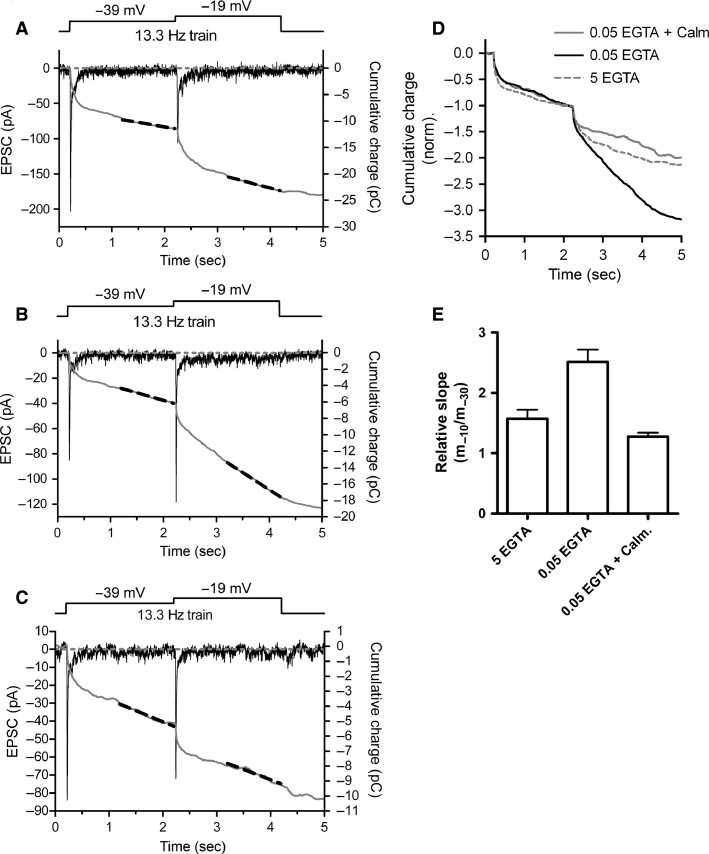
Reduced Ca2+ buffering promotes Ca2+/calmodulin-dependent acceleration of replenishment in cones. (A) Paired cone-HC recording in which the cone was stimulated with a train of depolarizing pulses (25 msec duration, 13.3 Hz) to –39 mV for 2 sec followed by –19 mV for 2 sec (Vhold = –79 mV). The black trace is the postsynaptic current (left axis). The dashed horizontal gray line is the prestimulus baseline. The gray trace is the cumulative charge of the EPSC (right axis). Baseline synaptic input was subtracted by adjusting the slope of the prestimulus baseline. Replenishment rate was measured as the slope of a linear fit (black dashed lines) to the last 1 sec at –39 and –19 mV. Under these conditions, in which release is limited by the rate of replenishment, the increase in slope represents an increase in replenishment rate. (B) A similar recording in which the cone pipette solution contained 0.05 mmol/L EGTA to mimic endogenous buffering conditions. Under these conditions, the change in slope measured with the transition from –39 to –19 mV was greater, indicating that 0.05 mmol/L EGTA enhances replenishment rate. (C) Bath application of the calmodulin inhibitor calmidazolium (20 μmol/L) reduced the change in slope accompanying the transition from –39 mV to –19 mV. (D) EPSC cumulative charge traces from A to C normalized to the 2 sec time point to emphasize the differences in the relative slope under different experimental conditions. (E) Group data of relative slope (slope–10/slope–30) showing that the increase in replenishment rate was enhanced when the cone pipette contained 0.05 mmol/L EGTA. This enhancement from 0.05 mmol/L EGTA was inhibited when the retinal slices were treated with 20 μmol/L calmidazolium.